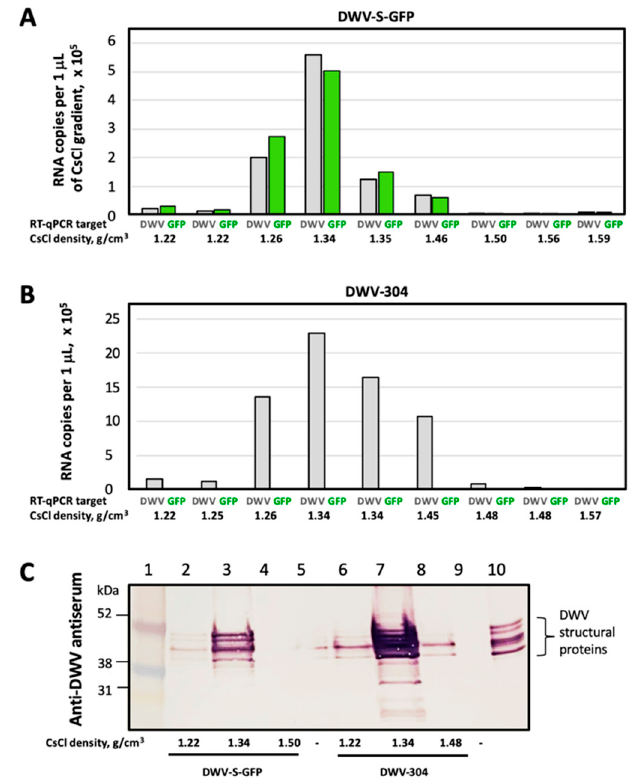
Figure 4. Encapsidation of the DWV-S-GFP genomic RNA. Virus particles accumulated in the honey bee pupae infected with ( A ) DWV-S-GFP and ( B ) DWV-304 in vitro RNA transcripts, 72 hpi were separated by CsCl buoyant density gradient centrifugations. The DWV and GFP RNA levels were quantified by RT-qPCR in the density gradient fractions indicated shown below. ( C ) Western blot analysis of the gradient fractions using antiserum to DWV virus particles. Lane 1, molecular weight standards; lanes 2–4, DWV-S-GFP CsCl gradient fractions; lanes 6–8, DWV-304 CsCl gradient fractions; lane 10, pupae infected with DWV-S-GFP; lanes 5 and 9, empty; lane 10 – extract from DWV-infected honeybee tissue.